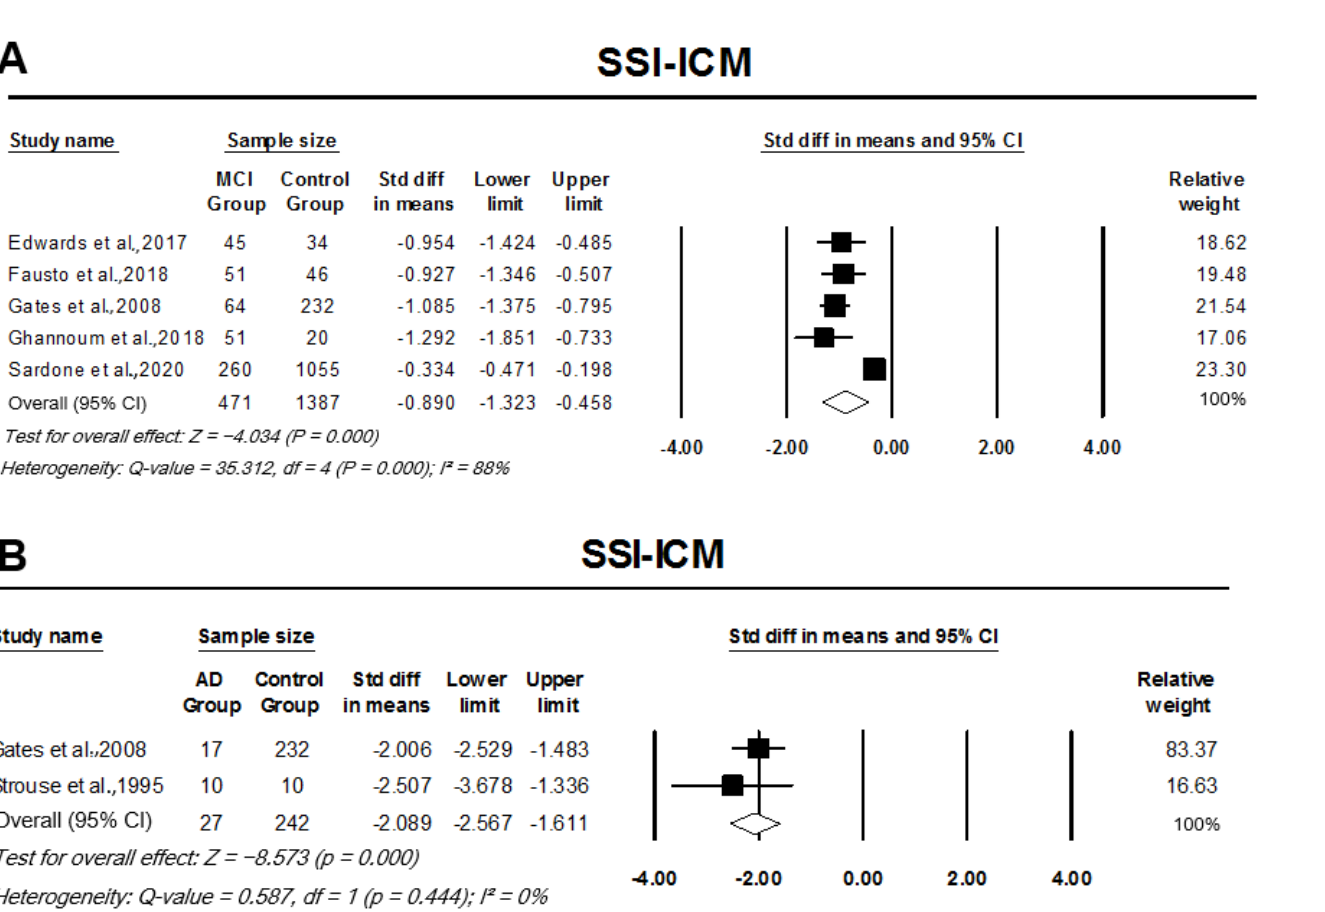
Figure 6. Forest plot of standard mean difference and overall (pooled) estimate of studies investi- gating speech perception in noise (SPIN) test that compared a mild cognitive impairment (MCI) group to a control group. Notes: Z= Z score; I 2 = percentage of heterogeneity; Q-value = Cochrane’s Q; df = degrees of freedom. The horizontal lines represent the 95% confidence interval (CI) for each computed standard mean difference. Weights are from the random-effects analysis.